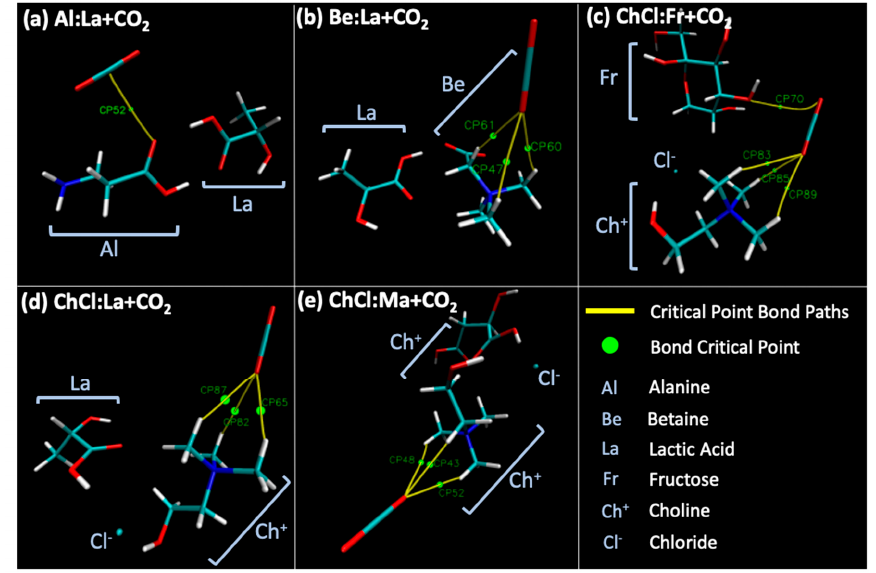
Figure 4. Density functional theory (DFT) figures for each structure final optimized